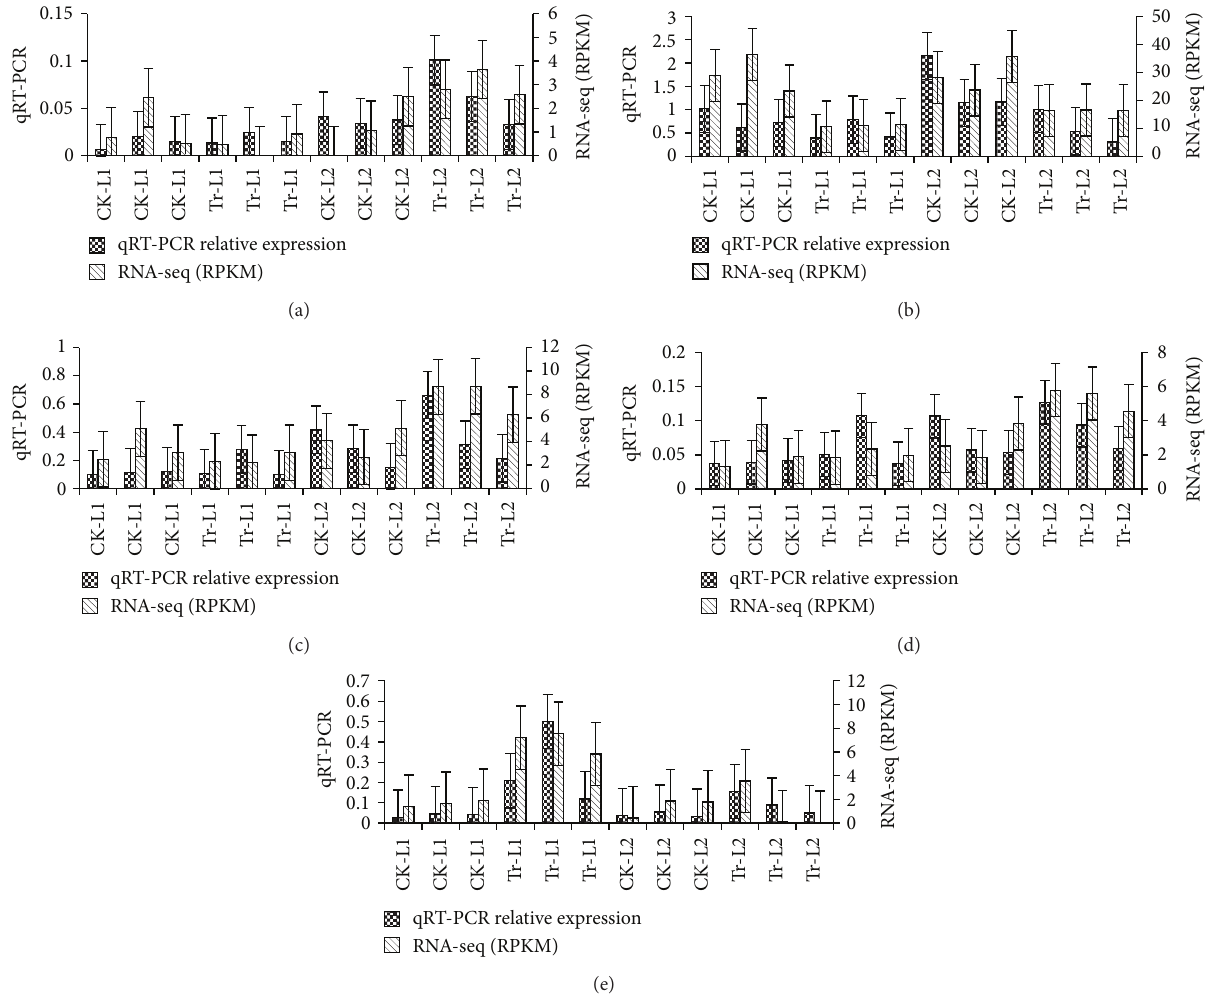
Figure8:ComparisonofgeneexpressionbetweenRNA-seqandqRT-PCR.Thedataweretransformedbysquareroot.Barsrepresentstandard deviation. (a) Csa1G066570 ( 𝑅 2 = 0.597 , 𝑝 = 0.0032 ), (b) Csa1G590300 ( 𝑅 2 = 0.519 , 𝑝 = 0.0082 ), (c) Csa5G589260 ( 𝑅 2 = 0.483 , 𝑝 = 0.0121